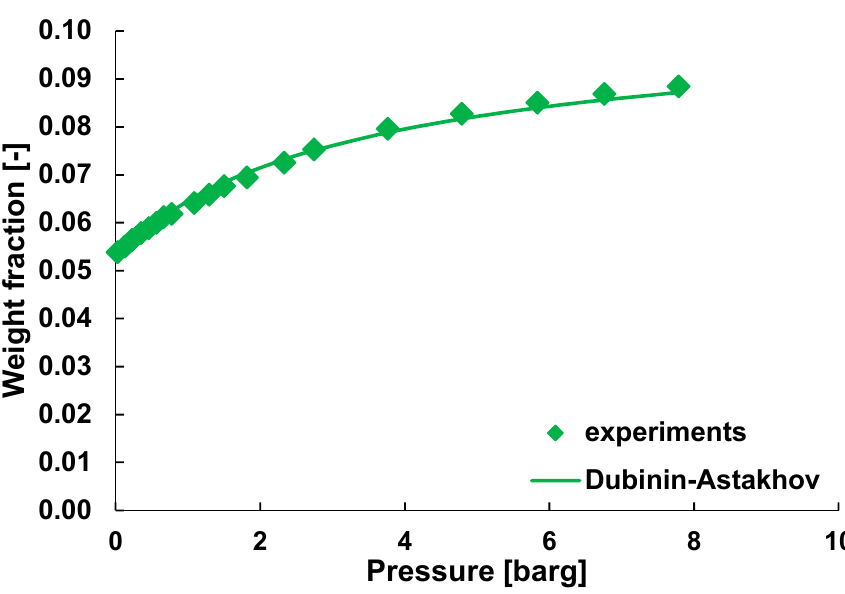
Figure 6. CO 2 Thermo-gravimetric analysis of CO 2 at 50 °C and isotherm adsorption curve, the sample is from CMSM-550.